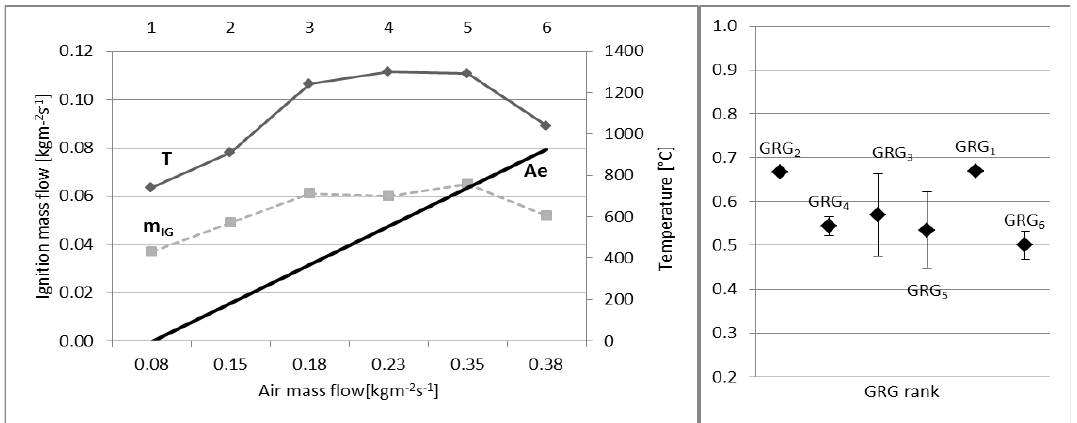
Figure 6. Air mass flow rate effect on the ignition mass flow rate and the front temperature of the brassica pellet (bp), and the GRG